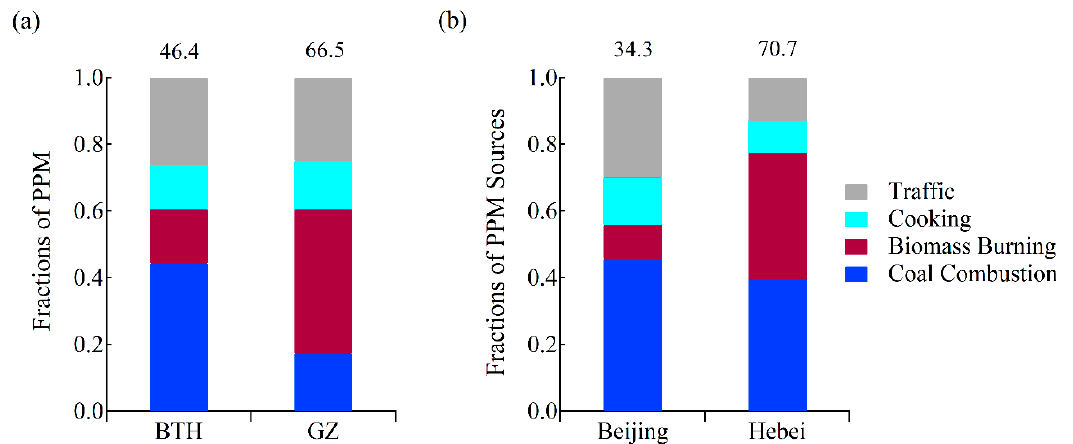
Figure 5. ( a ) Total contributions of the primary sources to primary particulate matter (PPM, including primary OA, chloride, and BC) in the Beijing-Tianjin-Hebei and Guanzhong regions, and in ( b ) Beijing and Hebei province of the Beijing-Tianjin-Hebei region. The numbers above the bars represent the average mass concentrations of PPM.